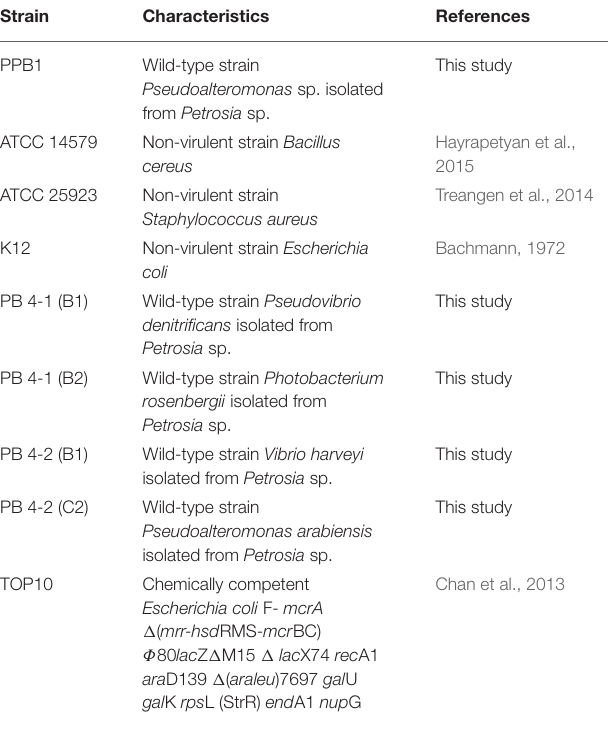
TABLE 1 | Bacterial strains used in this antibacterial assay and TA cloning.